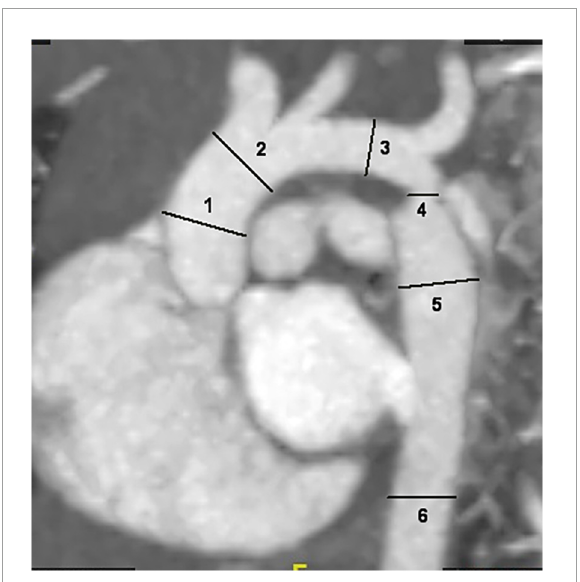
FIGURE1 Sagittal multiplanar reformatted image shows the measurement of aortic diameters at different levels: 1. ascending aorta; 2. pre-coarctation aorta; 3. aortic arch; 4. site of coarctation; 5. descending aorta after the site of coarctation; 6. descending aorta at level of diaphragm.